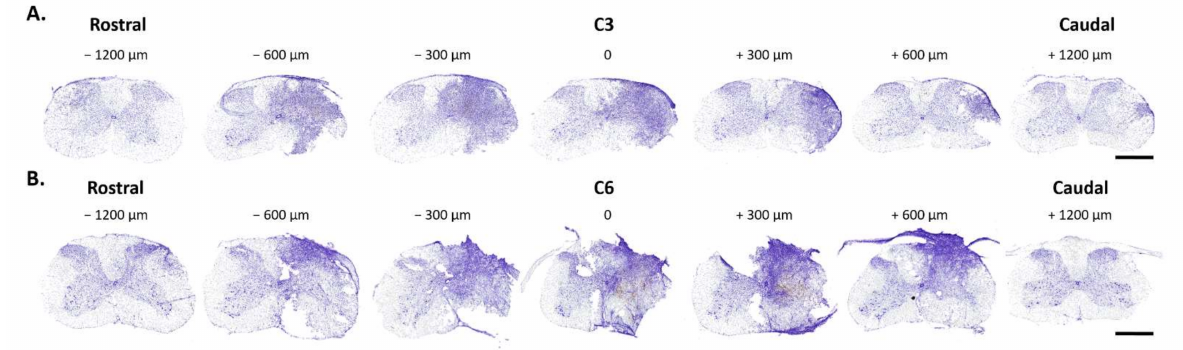
Figure 1. Examples of extent of injury to C3 and C6 spinal segments in mice 7 days post-contusion . Representative examples of cresyl violet staining at the injured site 7 days post-contusion for C3- ( n = 6) ( A ) and C6- ( n = 6) ( B ) injured groups. Representative images showing immunolabeling of glial fibrillary acidic protein (GFAP) (glial cells, in green), NeuroTrace (neurons in red) and ionized calcium-binding adaptor protein-1 (Iba1) (microglia, aqua) for C3-contused group ( C ) and C6-contused group ( D ). Note that half of the spinal cord is completely injured by the contusion for both groups, and no neurons remained in the scar. Scale bar: 500 µ m.